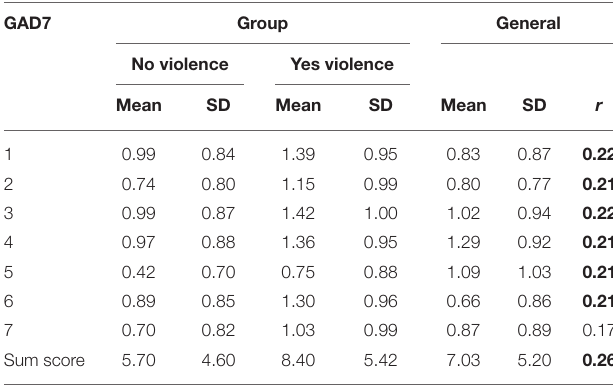
TABLE 2 | Mean, standard deviation, and r coefficient differences between groups. GAD7 Group General